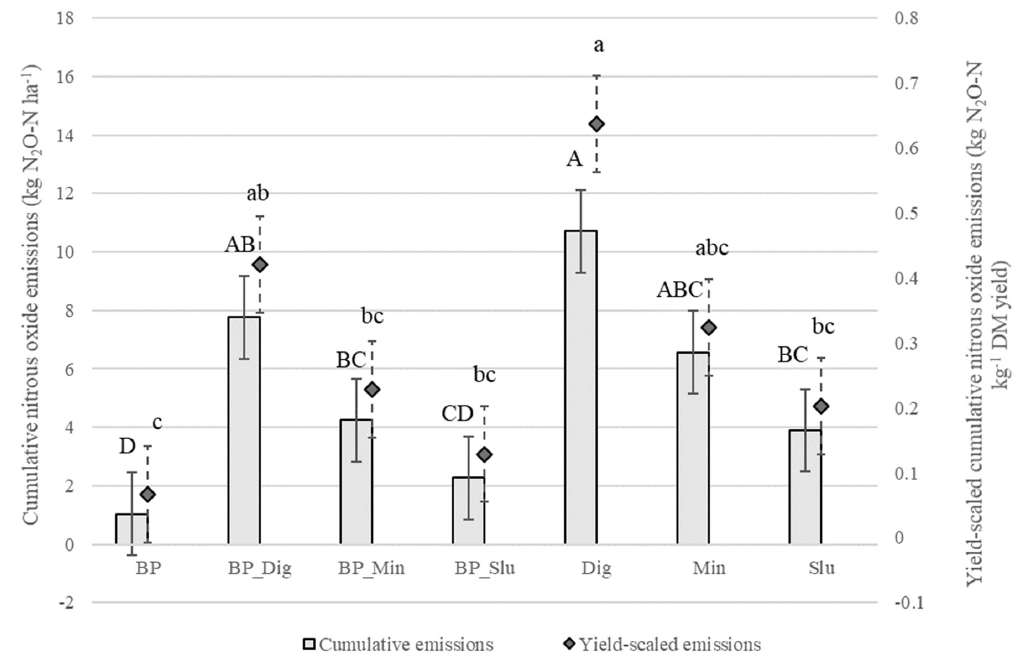
Figure 7. Cumulative (kg N 2 O–N ha − 1 ) and yield-scaled (kg N 2 O–N Mg − 1 of DM yield) nitrous oxide emissions of a complete maize cropping cycle (2019) for BP-treated plots at the D2 dose, and the corresponding fertilized controls. Different letters refer to significantly different mean values. Capital letters are used for cumulative emissions, while lowercase letters for yield-scaled emissions.